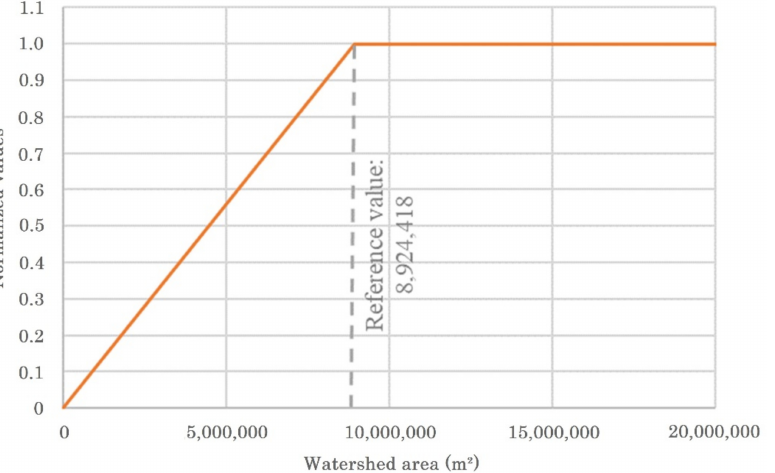
Figure 5. Normalization function used to calculate the hydrological vulnerability and in the normal- ization of the average area of all river crossings on a route.